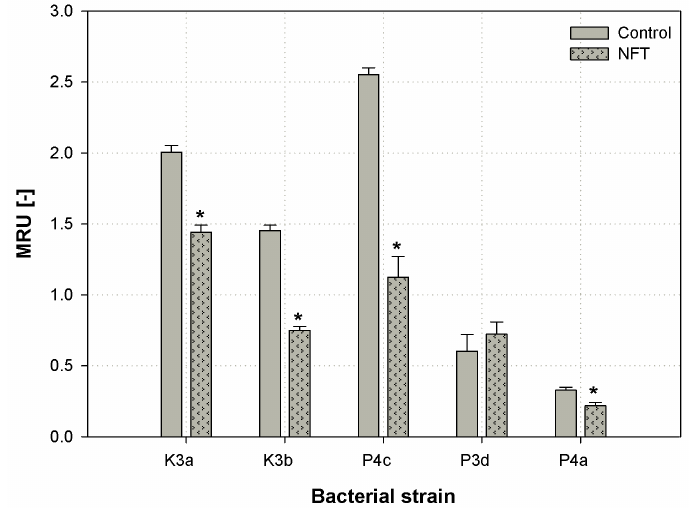
Figure 6. Modifications of microbial cells’ viability in microbial cultures subjected and not subjected to contact with nitrofurantoin after 24 h of cultivating: Sphingomonas paucimobilis (K3a), Ochrobactrum antrophi (K3b), Rhizobium radiobacter (P4c), Pseudomonas aeruginosa (P4a), and Sphingobacterium thalpophilum (P3d); stars (*) above the columns indicate statistical differences among groups (samples treated with NFT vs. untreated controls, p < 0.05, ANOVA followed by Tukey’s range test); results are reported as mean values calculated from three independent experiments.